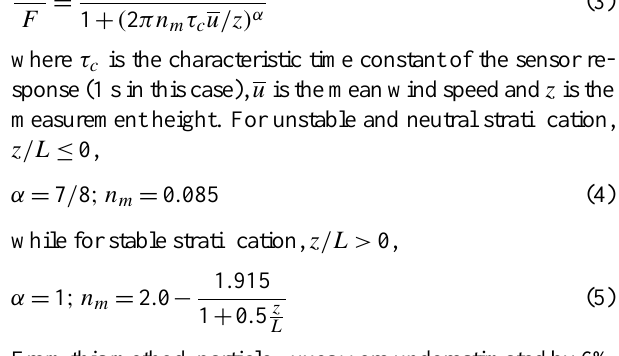
2778 mm (L. S. Fook, Malaysia Meteorological Dept.,